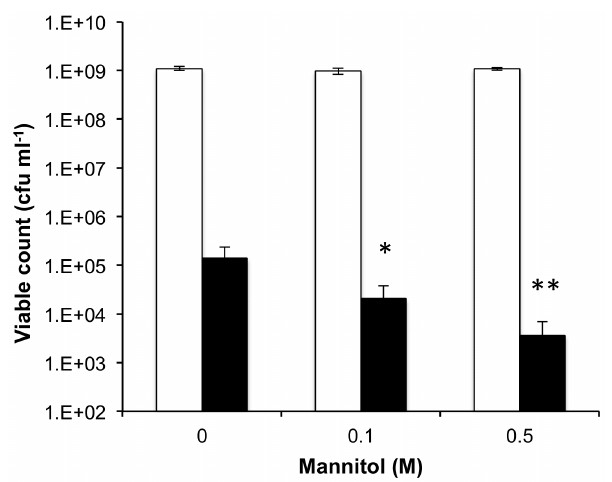
Figure 7. Growth of S.aureus in the presence of mannitol and linoleic acid. Bacteria were cultured on BHI agar containing either no or added mannitol (0.1 M, 0.5 M) in the presence (black bars) or absence (white bars) of 1 mM linoleic acid. Differences in viable cells recovered in the presence of mannitol were significantly reduced compared to the absence of mannitol (P=0.03 and P=0.001 for 0.1 M and 0.5 M, respectively).